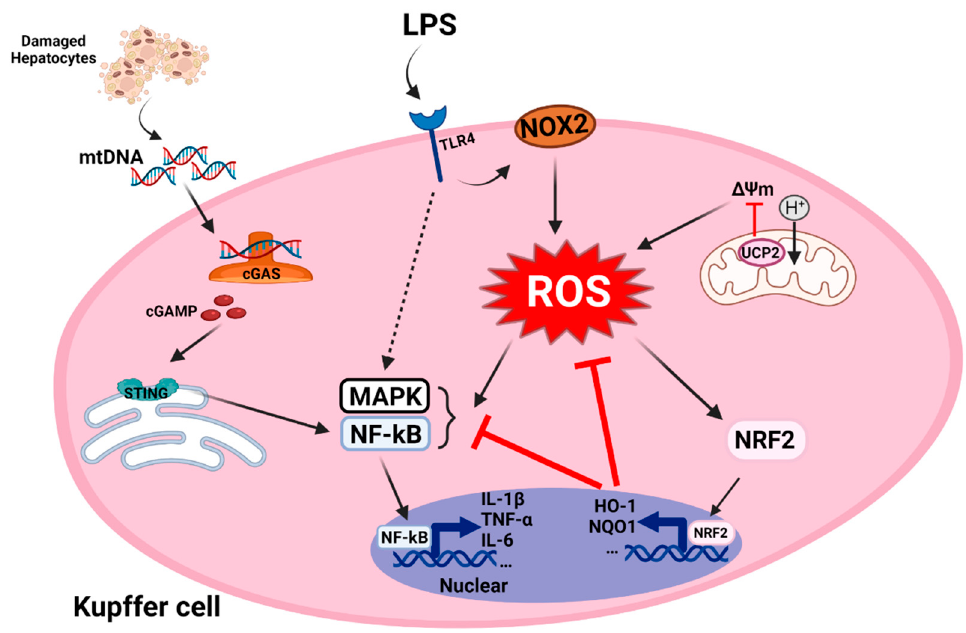
Figure 3. The mechanism of ROS involved in pro-inflammatory Kupffer cells. Fatty acid intake increases lipid accumulation in hepatocytes, whereas oxidative stress involves the release of mtDNA from damaged hepatocytes. KCs activated by mtDNA promotes the secretion of pro-inflammatory factors through the cGAS/STING axis and is dependent on the NF-kB pathway. LPS-mediated inflammation through activation of MAPK and NF-kB pathways. Meanwhile, LPS activates TLR4 to promote NOX2 production of ROS. Large amounts of ROS increase MAPK and NF-kB transcription and promote production of inflammatory cytokines as well as (IL-1 β , TNF- α , and IL-6, etc.). Mitochondria are the main organelle for ROS production, and UCP2 localized in the inner mitochondrial membrane increase proton transfer to downregulate mitochondrial membrane potential to control ROS levels. NRF2 regulate negatively ROS by increasing the production of antioxidant factors.